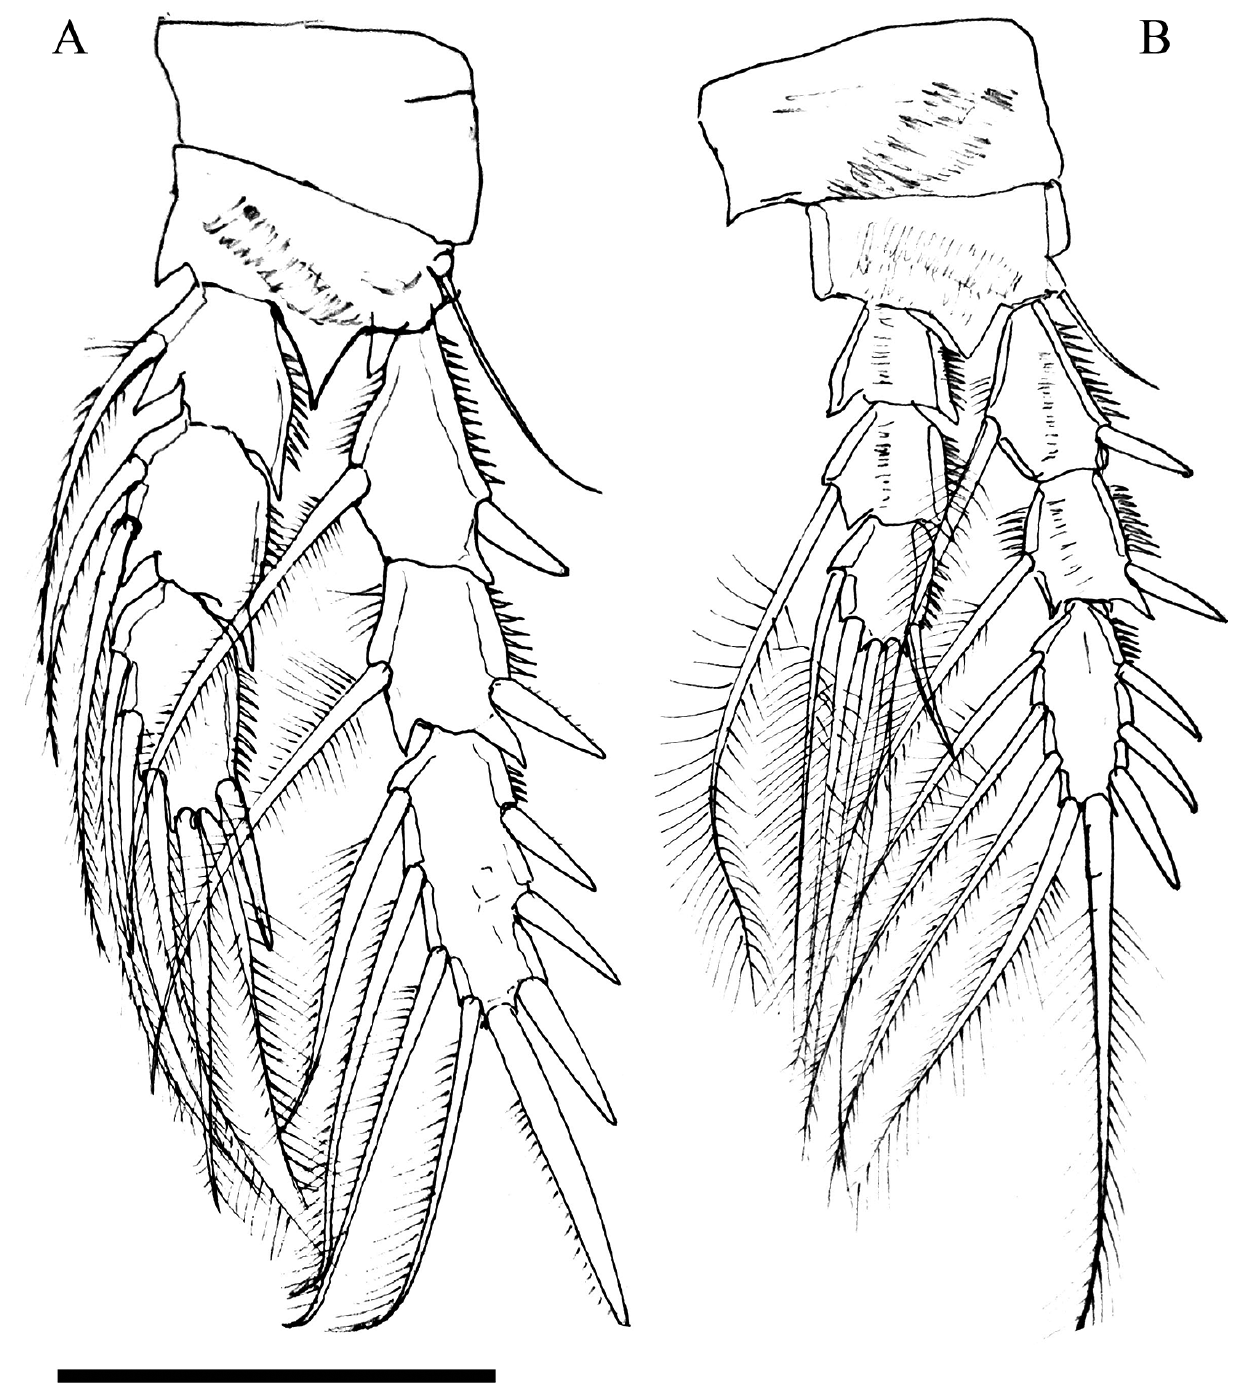
Figure 6. Eudactylopus fasciatus Sewell, 1940, female (A) P3, anterior ; (B) P4, anterior . Scale bar 100